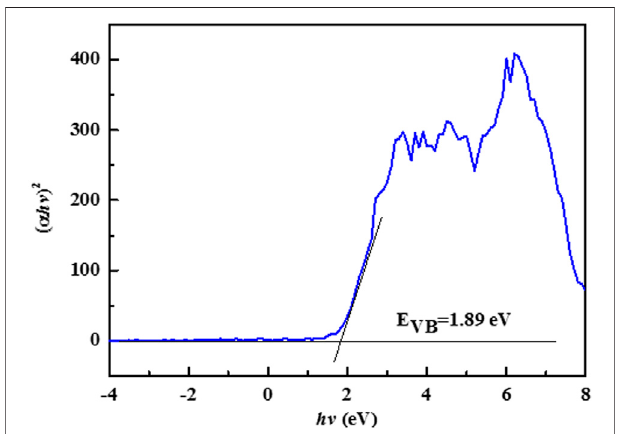
FIGURE 7 | Upconverted PL spectra of CDs with excitation wavelength of 350 nm; inset: fl uorescent picture of CDs under UV-light